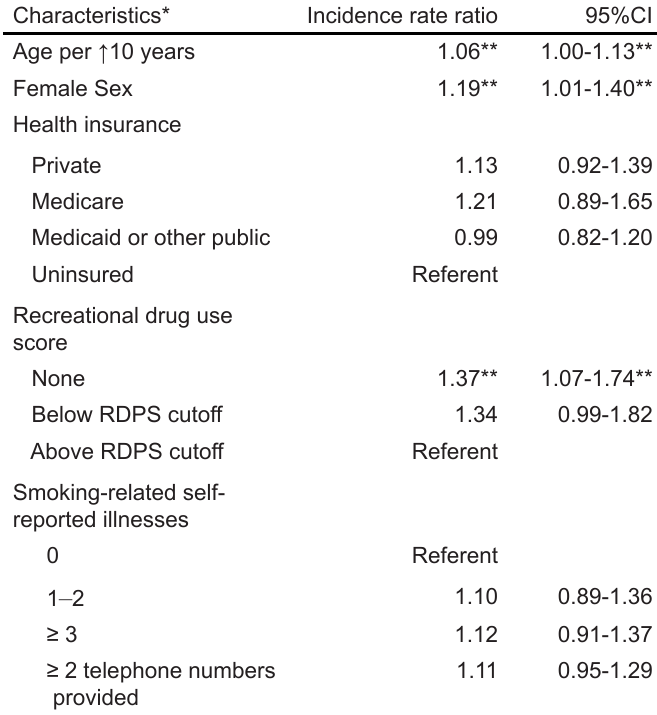
Table 4. Multivariable Poisson regression for number of successful follow-up contacts (range